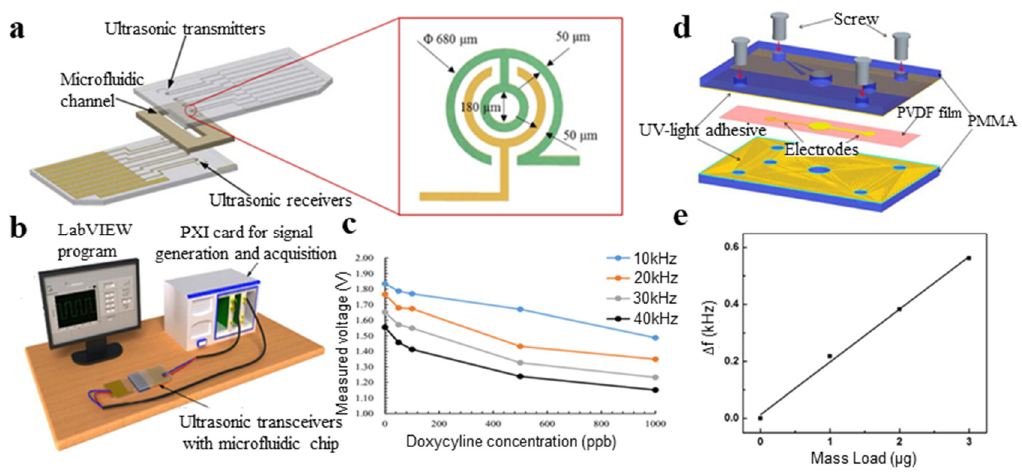
Figure 13. ( a ) Schematic of the chip [164]; ( b ) the experimental setup for characterizing the ultrasonic transceivers [164]; ( c ) the plastic microfluidic chip with ultrasonic transceivers [164]; ( d ) schematic of the biosensor using PVDF film as piezoelectric layer [166]; and ( e ) relationship between mass load and frequency shift ( ∆ f) [166].